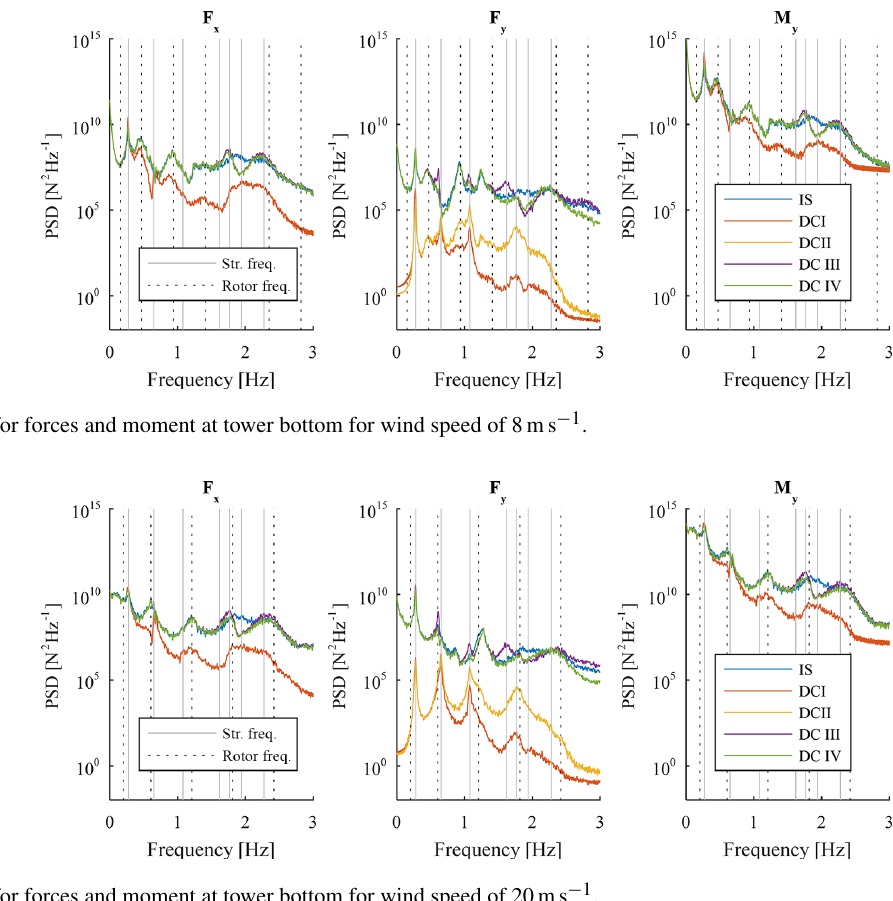
Figure 21. PSD for forces and moment at tower bottom for wind speed of 20ms − 1